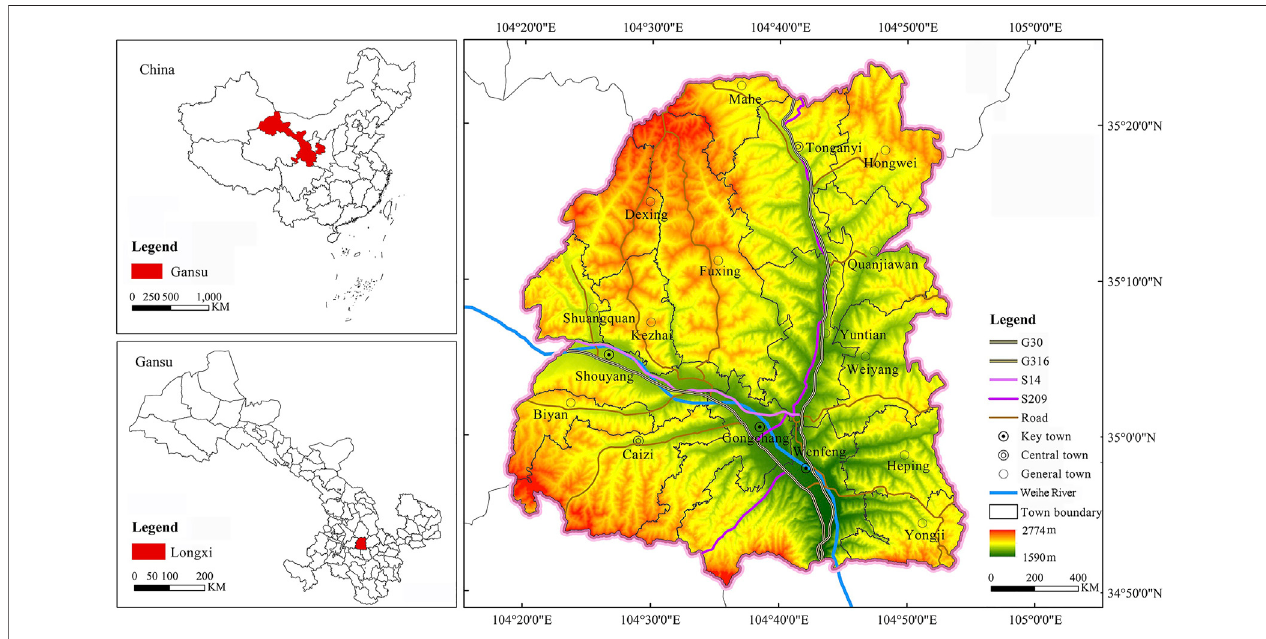
FIGURE 1 | Location of Longxi